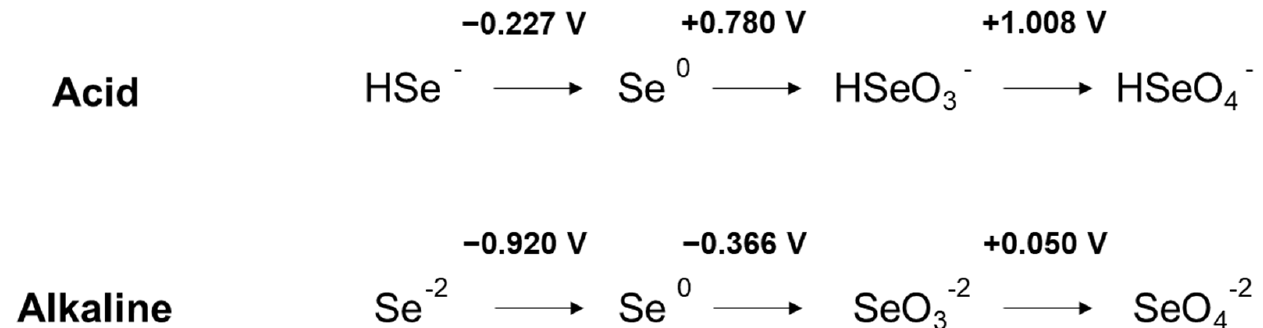
Figure 1. The redox potentials of selenium in acid and alkaline Figure 1. T he redox potentials of selenium in acid and alkaline solutions.